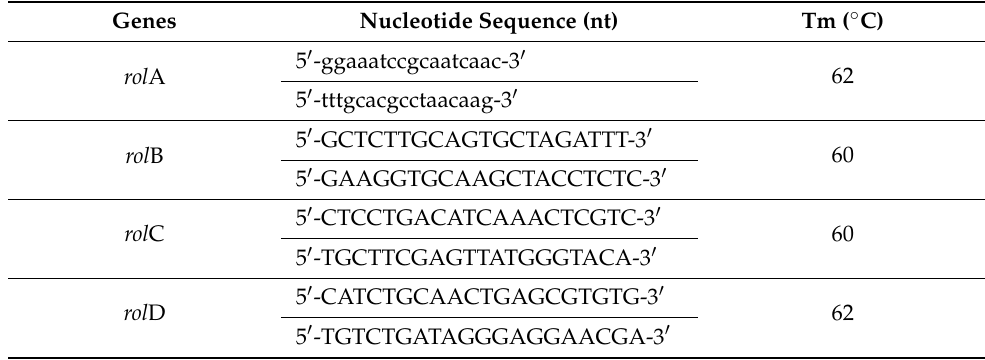
Table 3. Nucleotide sequence of primers used for detection of rol -genes in hairy root cultures. Genes